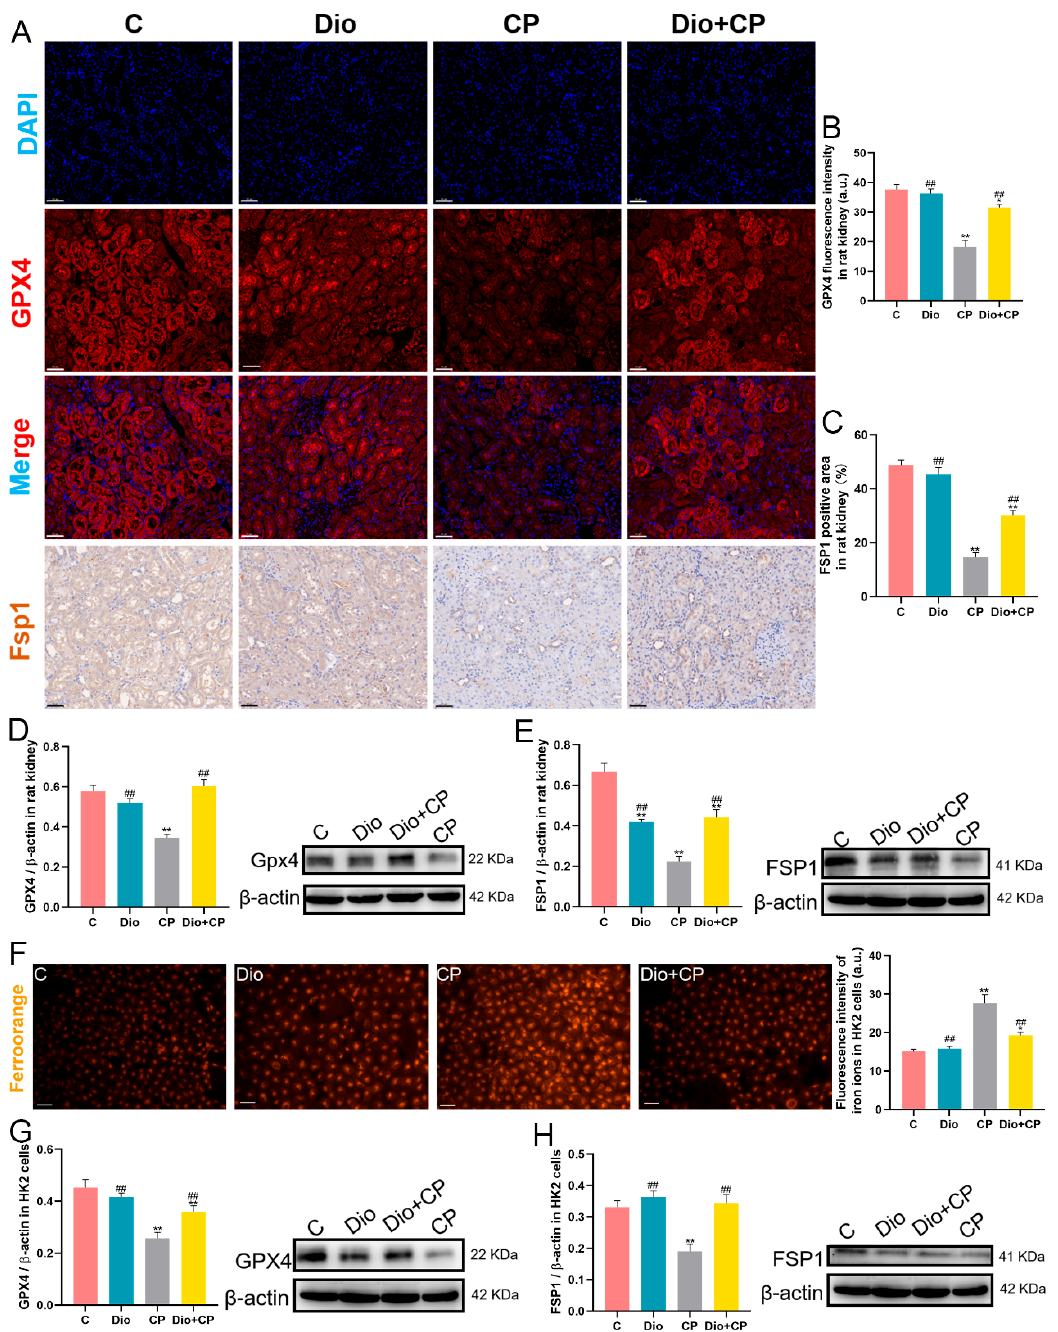
Figure 4. Dioscin improves cisplatin-induced ferroptosis in rat kidney and HK2 cells. ( A – C ) Representative images and quantification of GPX4 immunofluorescence (scale bar = 50 μ m) and FSP1 immunohistochemistry (scale bar = 50 μ m) in rat kidneys (n = 5). ( D , E ) The protein expressions of GPX4 and FSP1 in rat kidneys (n = 3). ( F ) Representative images and quantification of ferro orange staining (scale bar = 50 μ m) in HK2 cells (n = 5). ( G , H ) The protein levels of GPX4 and FSP1 in HK2 cells (n = 3). C, control group; Dio, dioscin group; CP, cisplatin group; Dio + CP, dioscin + cisplatin group. Results are presented as Mean ± SD. Statistical significance was obtained by one-way ANOVA. * p < 0.05, ** p < 0.01 compared with C group. ## p < 0.01 compared with CP group.